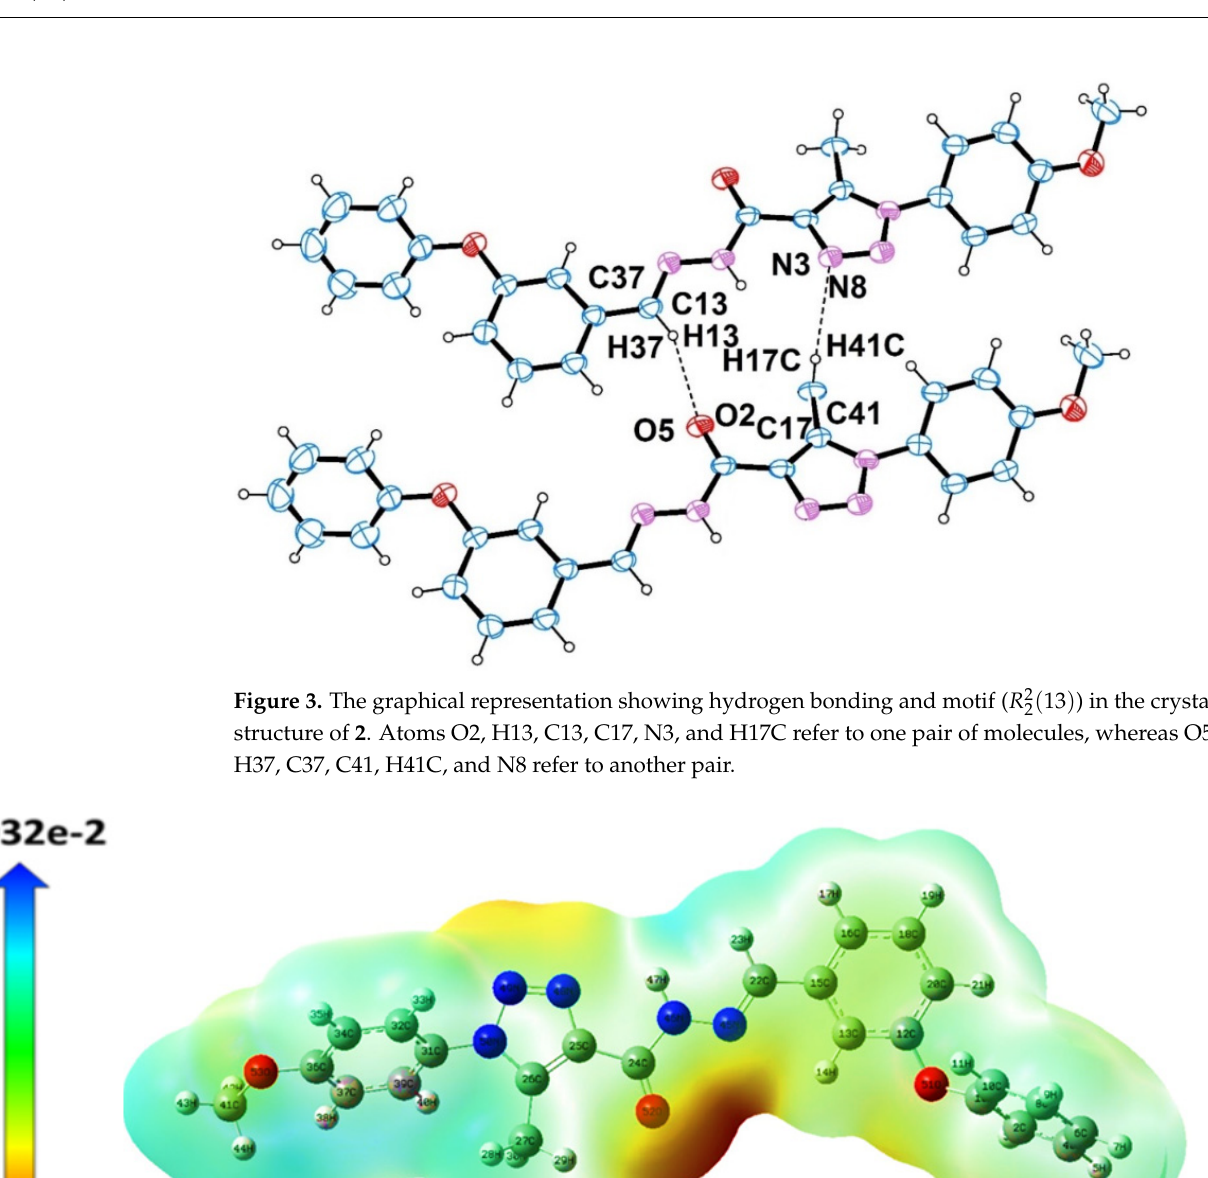
Figure 4. The MEPS for the optimized geometry of 2 (DFT/B3LYP/6-311++G(d,p)). Some selected structural parameters revealed from the X-ray diffraction and calcu- lated by the DFT/B3LYP/6-311++G(d,p) level are listed in Table 2. The computed R 2 values are 0.9722 (y = 1.0616x − 0.0825) for the bond lengths, 0.9387 (y = 0.9279x + 9.601) for the bond angles, and 0.9907 (y = 1.0041x − 2.6247) for the torsion angles at the 6-311++G(d,p) level. The optimized geometry of the 1,2,3-triazole ring shows N–N and N=N bond